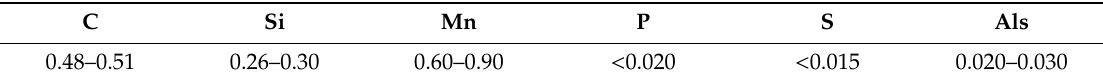
Table 1. Chemical compositions of the target steel grades A%.